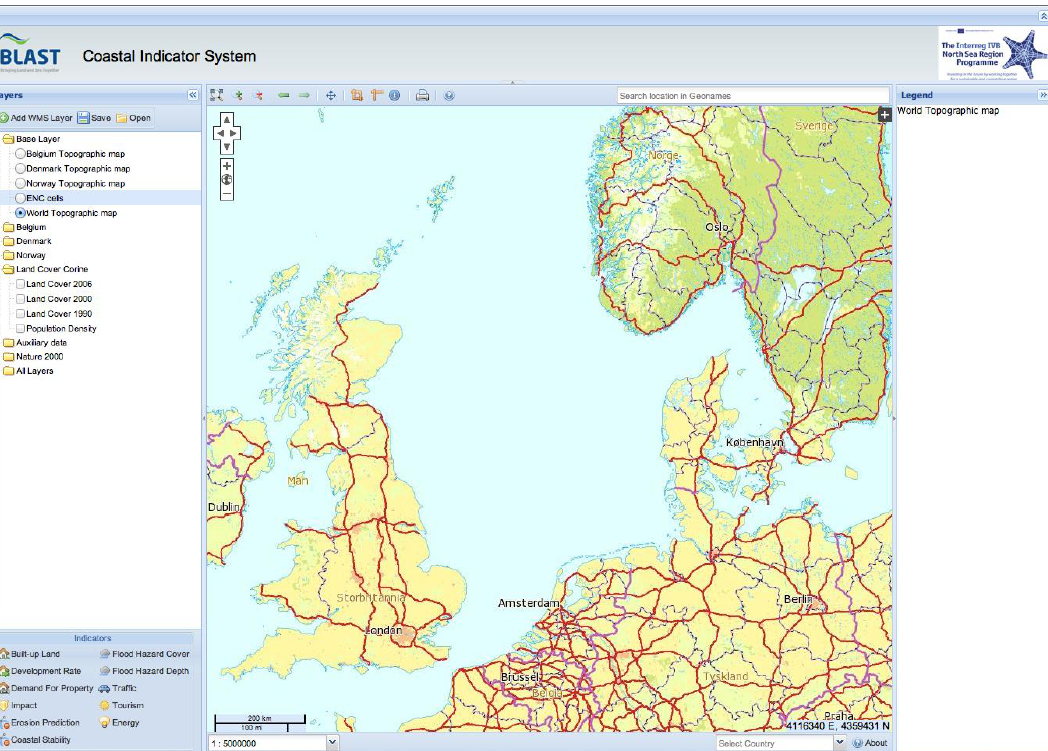
Figure 4. The user interface of the Costal Indicator